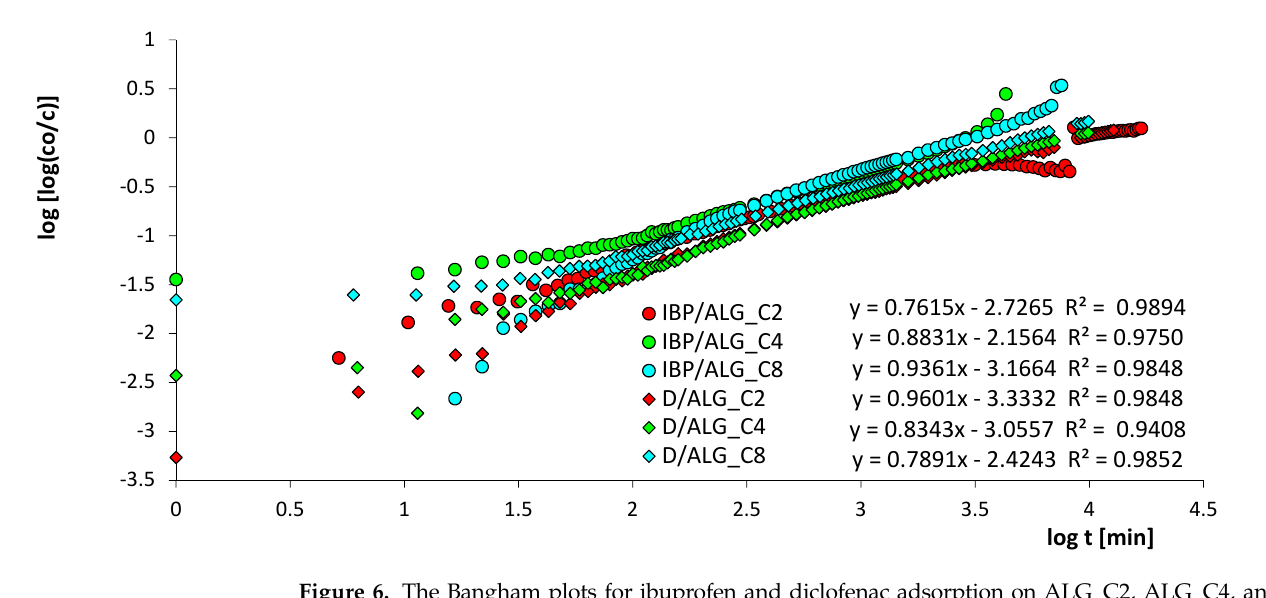
Figure 6. The Bangham plots for ibuprofen and diclofenac adsorption on ALG_C2, ALG_C4, and ALG_C8. Table 4. Relative standard deviations SD(c)/c o (%) for m-exp, FOE, SOE, MOE, f-FOE, f-SOE, f-MOE equations, McKay pore diffusion (PDM), and IDM model (Crank).